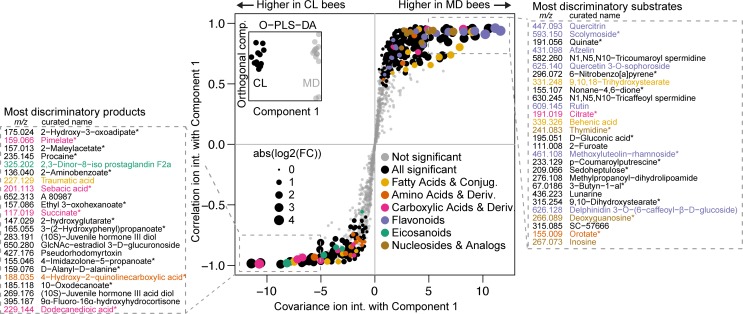
Metabolite changes between microbiota-depleted (MD) and colonized (CL) bees.An Orthogonal Projection of Least Squares-Differentiation Analysis (OPLS-DA) based S-plot of metabolite changes shows the ions responsible for CL and MD separation. The inset shows OPLS-DA separation between CL and MD along the component that was used for correlating ion intensities. Experiment 2 data (see S2A Data) was used for this plot, and annotated ions that were not robustly significantly different between CL and MD in both experiments are plotted in grey. Ions with a first annotation belonging to an enriched category (see S3A Data) are plotted in color, except for the category “amino acids and derivatives”, which did not meet the significance threshold for enrichment but was deemed relevant. The “purine nucleosides and analogues” and “pyrimidine nucleosides and analogues” categories were combined into “nucleosides and analogs” for coloring only. The boxed areas show the m/z [M-H+]- of the ion and the first annotation name of the most discriminatory ions, sorted by covariance. Asterisks indicate ions with ambiguous annotations. The numerical data can be found in S1 Data. Conjug., conjugates; Deriv., derivatives; FC, fold change; int., intensity.